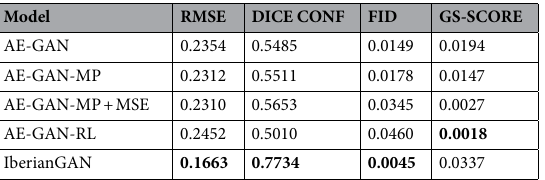
Table 1. Quantitative performance evaluation for different approaches using a dataset test. The best value per metric are in